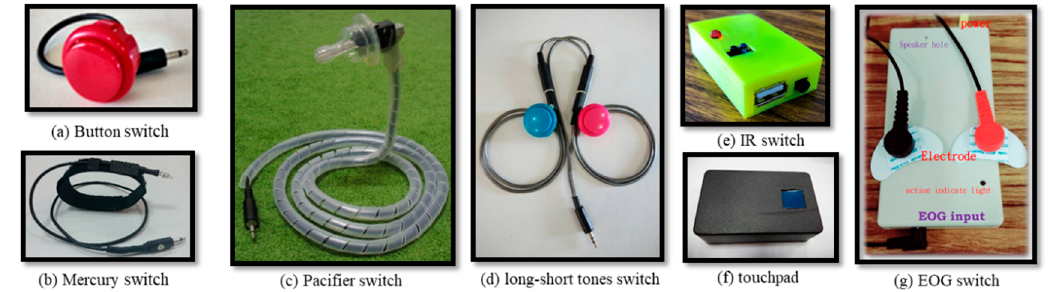
Figure 2. The kinds of input accessory . EOG: electrooculography.